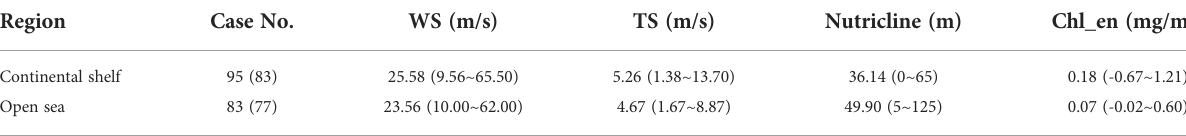
TABLE 1 The TC case numbers (those in parentheses show the number with a phytoplankton bloom, i.e., Chl_en >0), TC wind speed (WS), translation speed (TS), nutricline and TC-induced Chl_en in the continental shelf and open sea region in the SCS.